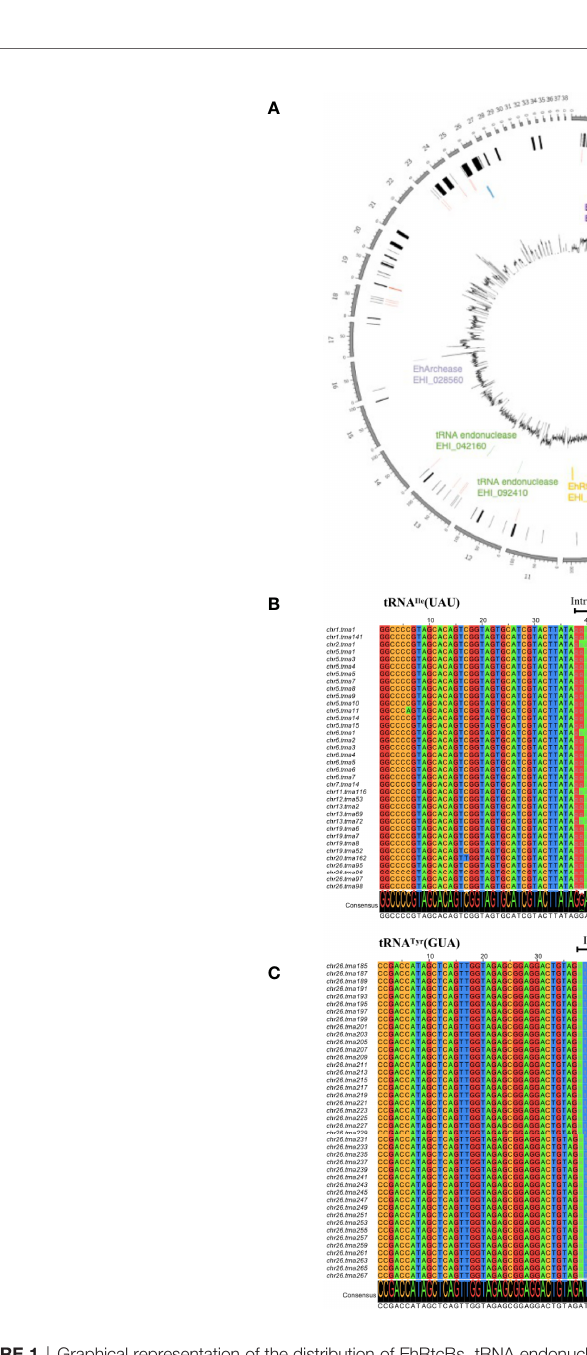
FIGURE 1 | Graphical representation of the distribution of EhRtcBs, tRNA endonucleases, EhArchease, 52 tRNA Ile (UAU), and 42 tRNA Tyr (GUA) genes in the E. histolytica genome and alignment of the representative tRNA Ile (UAU) and tRNA Tyr (GUA) genes. (A) tRNA Ile (UAU) genes are scattered throughout the genome, while tRNA Tyr (GUA) genes are clustered on a single chromosome. Locations of genes encoding EhRtcB1, EhArchease, and two tRNA endonucleases are also shown. (B) Sixteen pseudo genes were removed from predicted tRNA Ile (UAU) genes. Thirty-six remaining tRNA Ile (UAU) were aligned by clustalW and drawn by Jalview. Chromosomal location and the assigned tRNA gene number are indicated. Nucleotides are color-coded. The intron regions are shown in lowercase and highlighted with gray font. (C) Forty-two predicted tRNA Tyr (GUA) were aligned as in (B)